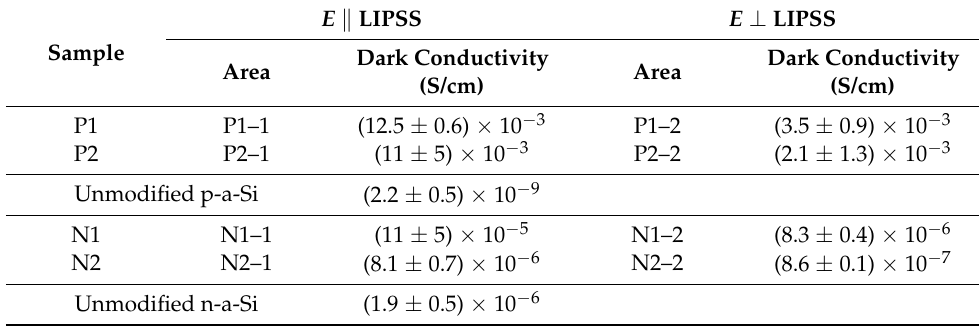
Table 3. Conductivity of the initial and modified p-a-Si and n-a-Si